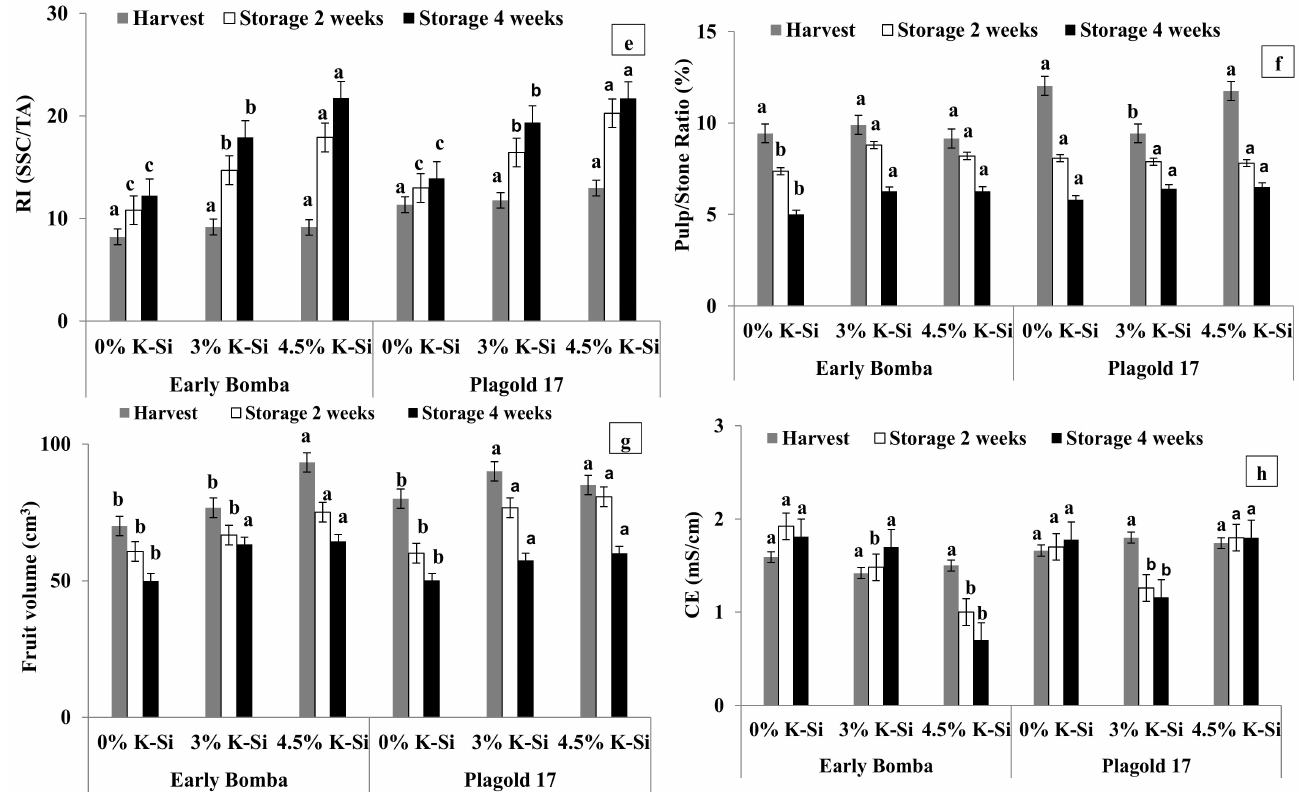
Figure 1. Impact of potassium silicon pretreatment and storage period on fruit weight ( a ), firmness ( b ), soluble solids content (SSC) ( c ), titratable acidity (TA) ( d ), ripening index (RI) ( e ), pulp stone ratio ( f ), fruit volume ( g ), and conductivity (CE) ( h ) in peach cultivars at harvest and after 2 or 4 weeks of cold storage (5 ◦ C and 95% Relative Humidity) during two growing seasons (2021/2022). Values are means ( n = 3) ± SE. Different letters a, b, indicate significant difference among K-Si treatments in each cultivar according to Scheffe’s multiple range